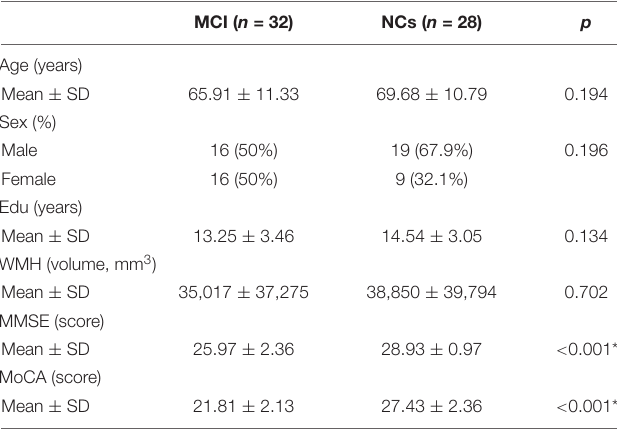
TABLE 1 | Demographic and clinical characteristics of patients with mild cognitive impairment (MCI) and control participants.